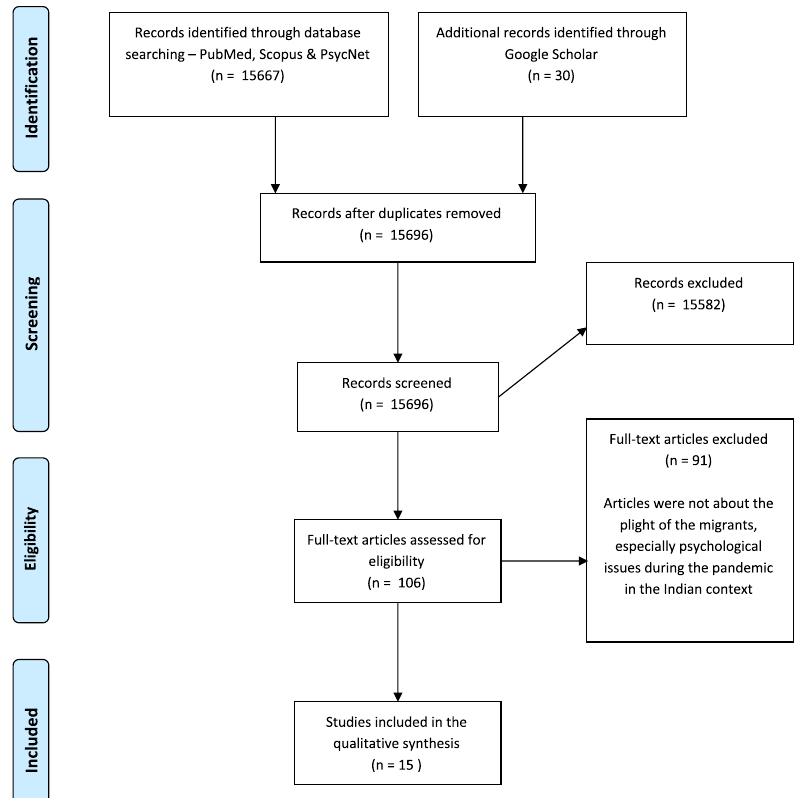
Fig. 1 The PRISMA fl ow diagram. Stages involved in fi nalizing the articles for analysis after obtaining the